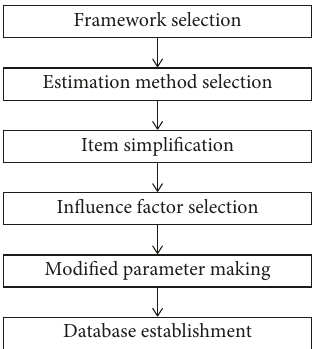
Figure 1: Cost model development